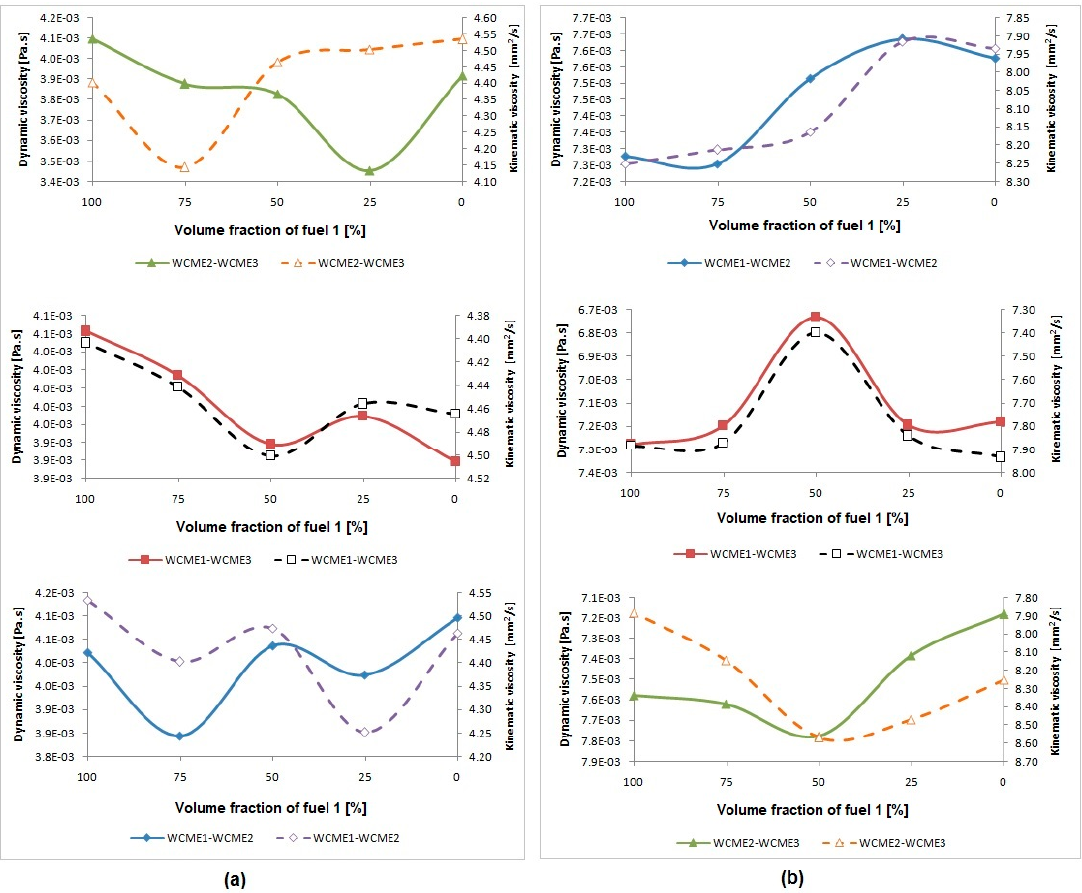
Figure 7. Viscosities versus volume fraction at; ( a ) the testing temperature of 40 ◦ C and ( b ) the testing temperature of 15 ◦ C (Dynamic viscosity: solid line; kinematic viscosity: dashed line).